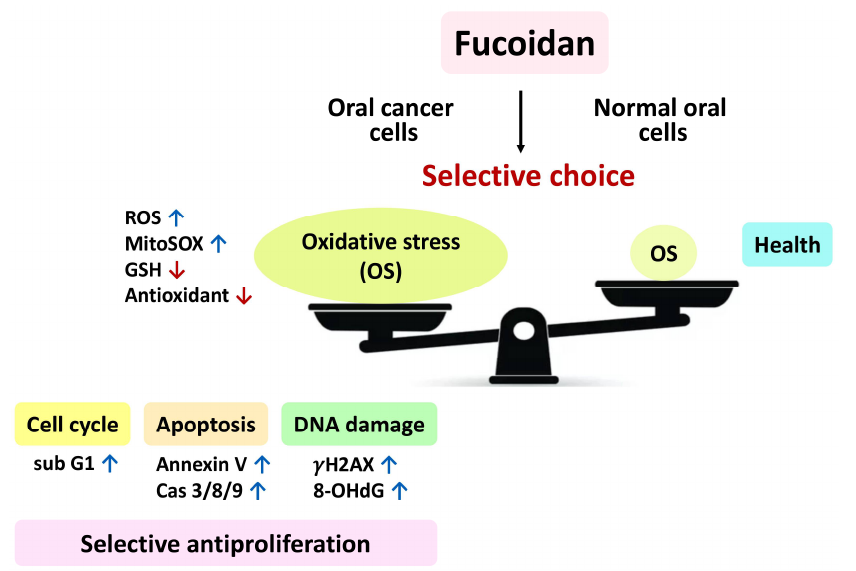
Figure 10. Overview of the preferential antiproliferation mechanism of fucoidan acting on oral cancer cells. In brief, fucoidan makes a preferential choice and then preferentially induces higher oxidative stress (OS) in oral cancer cells than in normal cells. In turn, this oxidative stress triggers a series of preferential responses in oral cancer cells, such as cell cycle arrest, apoptosis, and DNA damage. Finally, it causes preferential antiproliferation in oral cancer cells. In contrast, fucoidan only caused low levels of these changes, and normal cells showed healthy proliferation in the presence of fucoidan. Abbreviations: reactive oxygen species (ROS); mitochondrial superoxide (MitoSOX); glutathione (GSH); oxidative stress (OS); subG1 (subG1 phase); caspases 3/8/9 (Cas 3/8/9); 8-hydroxy-2-deoxyguanosine (8-OHdG). ↓ , ↑ , ↓ indicate making decision, upregulation, and downregulation, respectively.